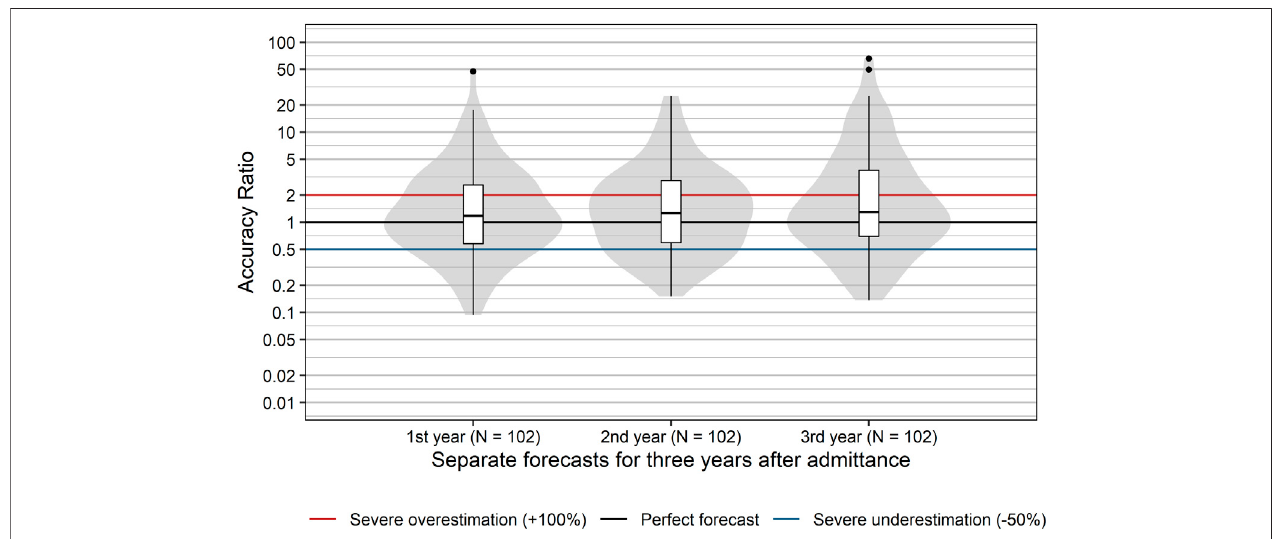
FIGURE2| Distributionofaccuracyratiosofproductswithapositivereimbursementdecision.Boxplotsandviolinplotsvisualizethedistribution ofaccuracyratios separately for the fi rst, second, and third year after admittance. Due to their asymmetric nature, accuracy ratios are plotted on a logarithmic (base 10) scale to avoid visually overemphasizing overestimates compared to